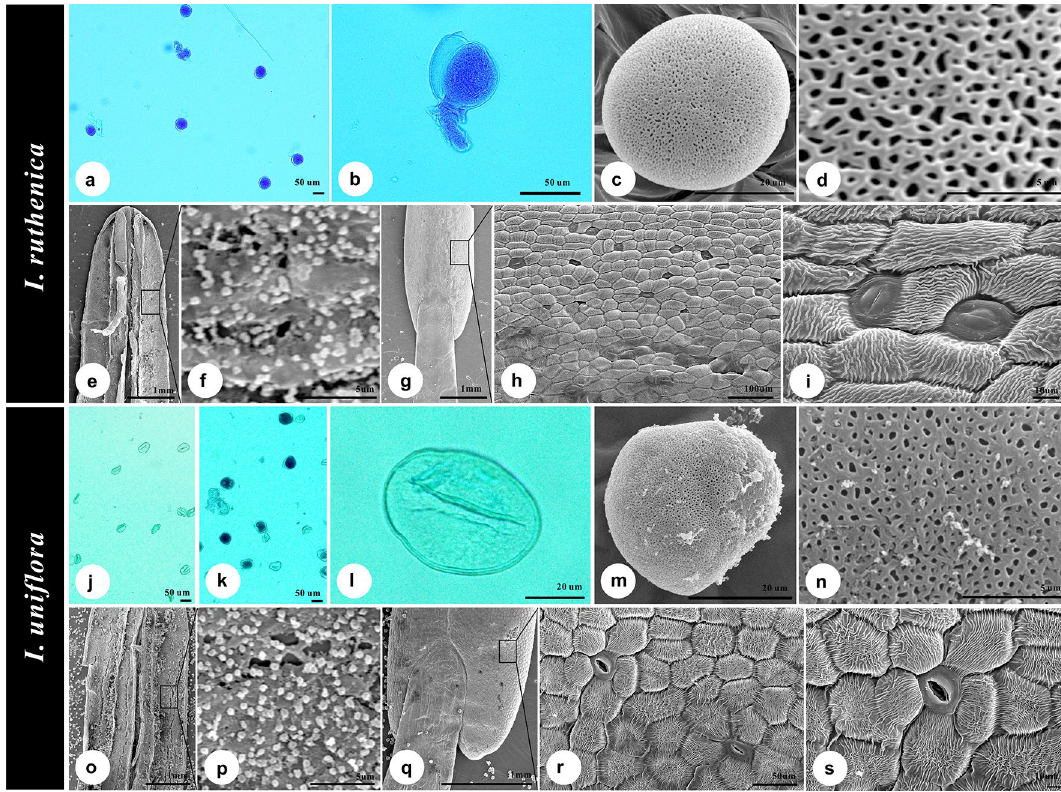
Figure 3. Stamen, pollen, and orbicule micromorphology of Iris ruthenica ( a – i ) and I. uniflora ( j – s ). ( a – d , j – n ) Stained fertile ( a , b ) or sterile ( j – l ) pollen grains and their detailed sexine ornamentation; ( e , f , o , p ) dissected anther (inner part; e , o ) and the occurrence of orbicules ( f , p ), respectively; ( g – i , q – s ) outer epidermis of anthers ( g , q ) and the occurrence of stomatal complex ( h , i , r , s ), respectively. All photographs were obtained by Bokyung